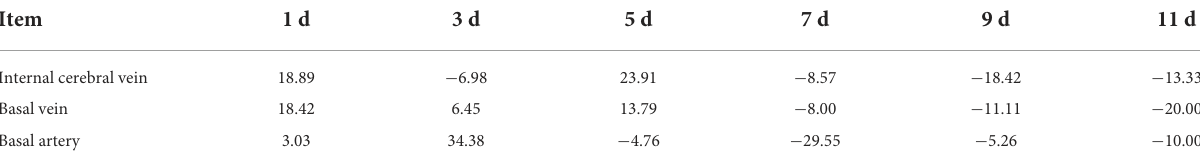
TABLE 2 The change rate of the internal cerebral vein, basilar vein, and basilar artery